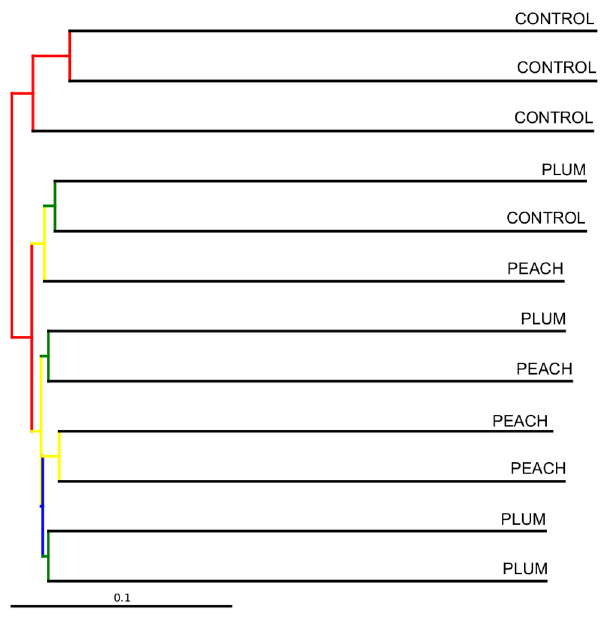
Figure 6. UPGMA hierarchical clustering using the unweighted Unifrac distance matrix. The colors represent different jackknife support: red (75–100% support); yellow (50–75%); green (25–50%); blue ( , 25% support). The bar represents community